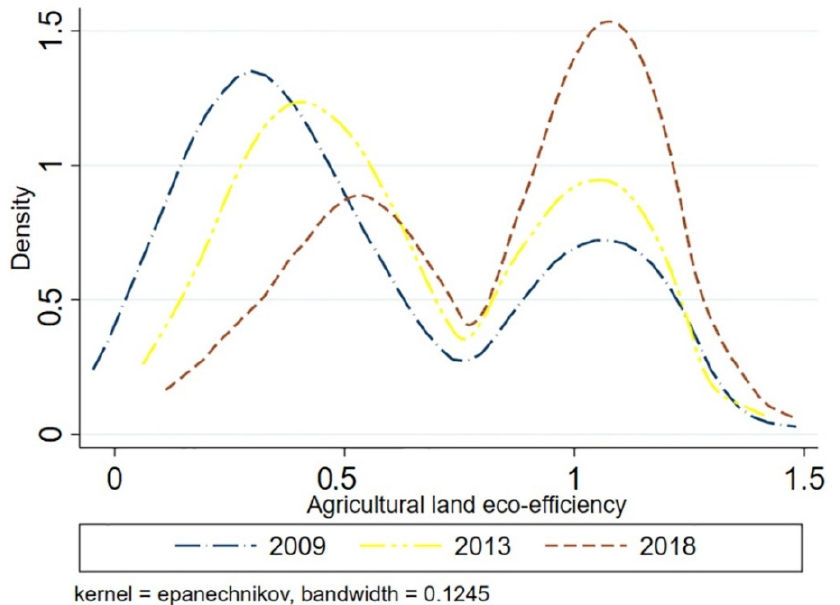
Figure 9. Kernel-density estimation of agricultural land eco-efficiency in the Yangtze River basin.